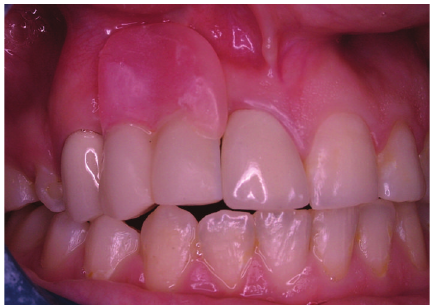
Figure 2: Prepared teeth.